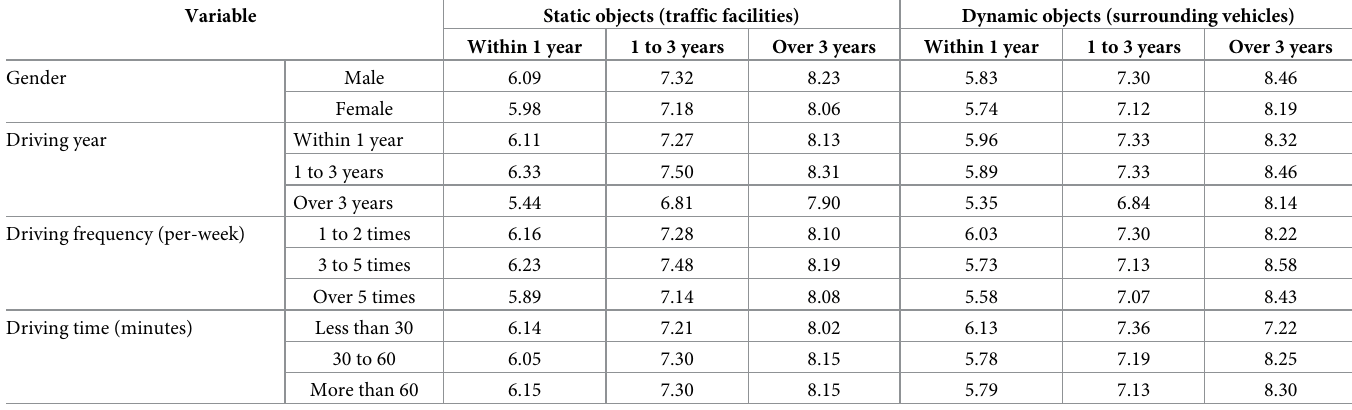
Table 3. Descriptive statistical of mean mutual-assessment score.